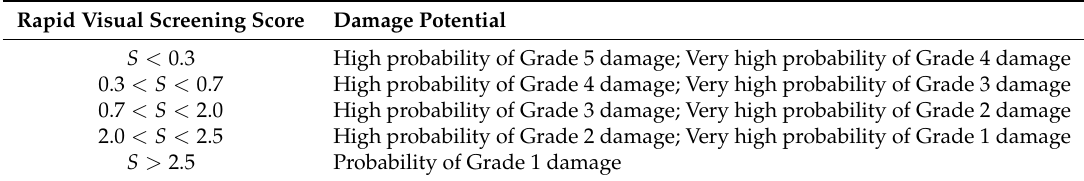
Table 2. Structural scores with damage potential